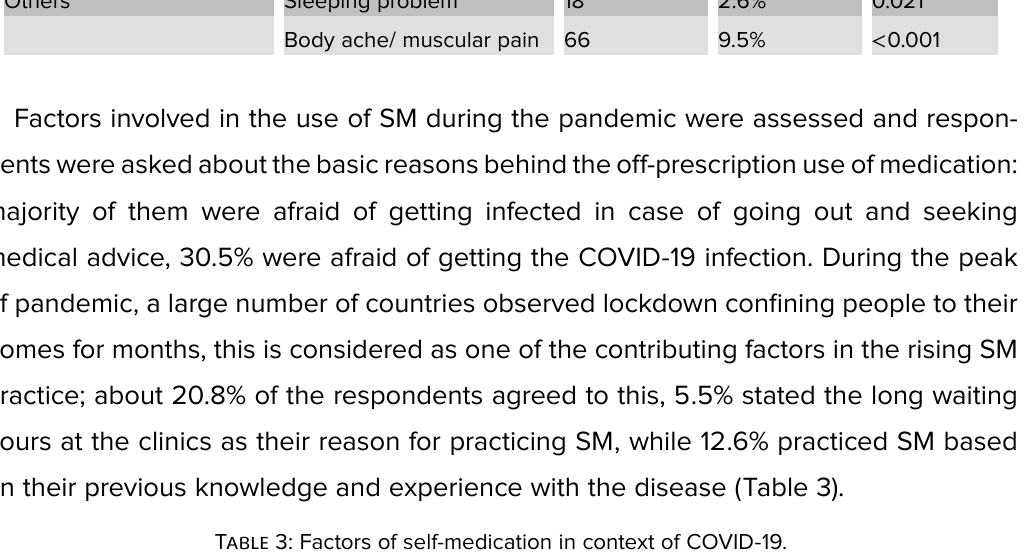
TABLE 3: Factors of self-medication in context of